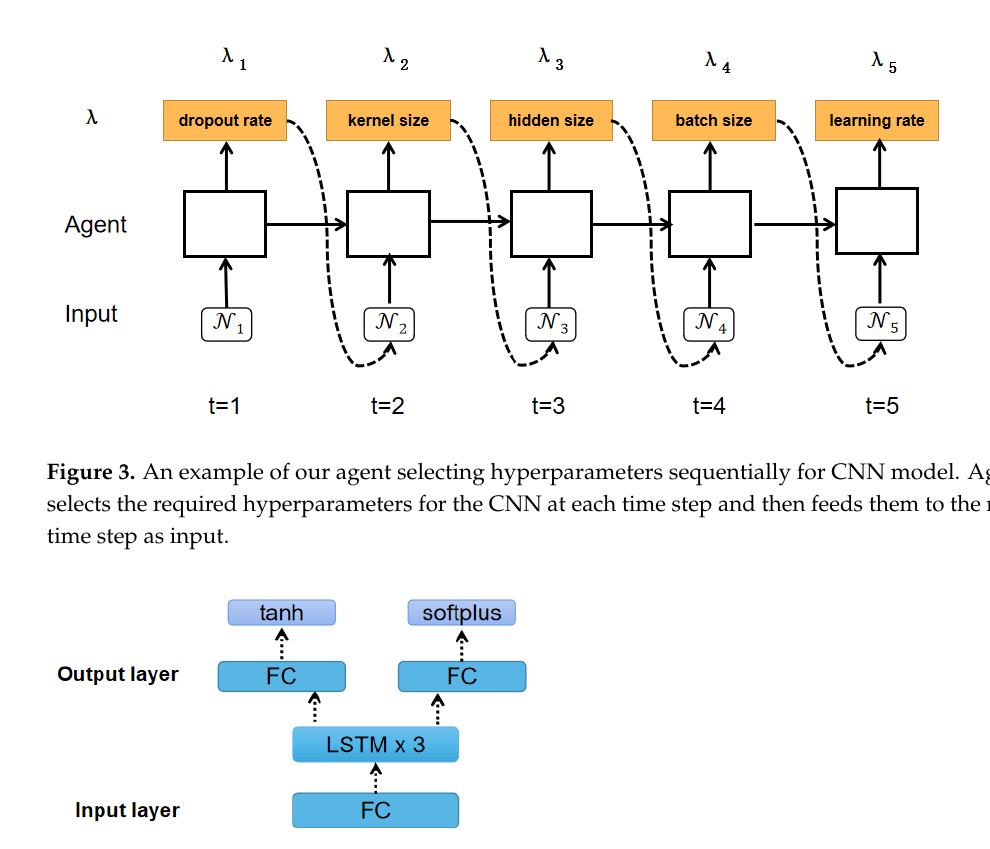
Figure 4. The structure of the agent. The agent consists of an input fully connected layer, three LSTM layers, and two output fully connected layers which use tanh and softplus activation functions,